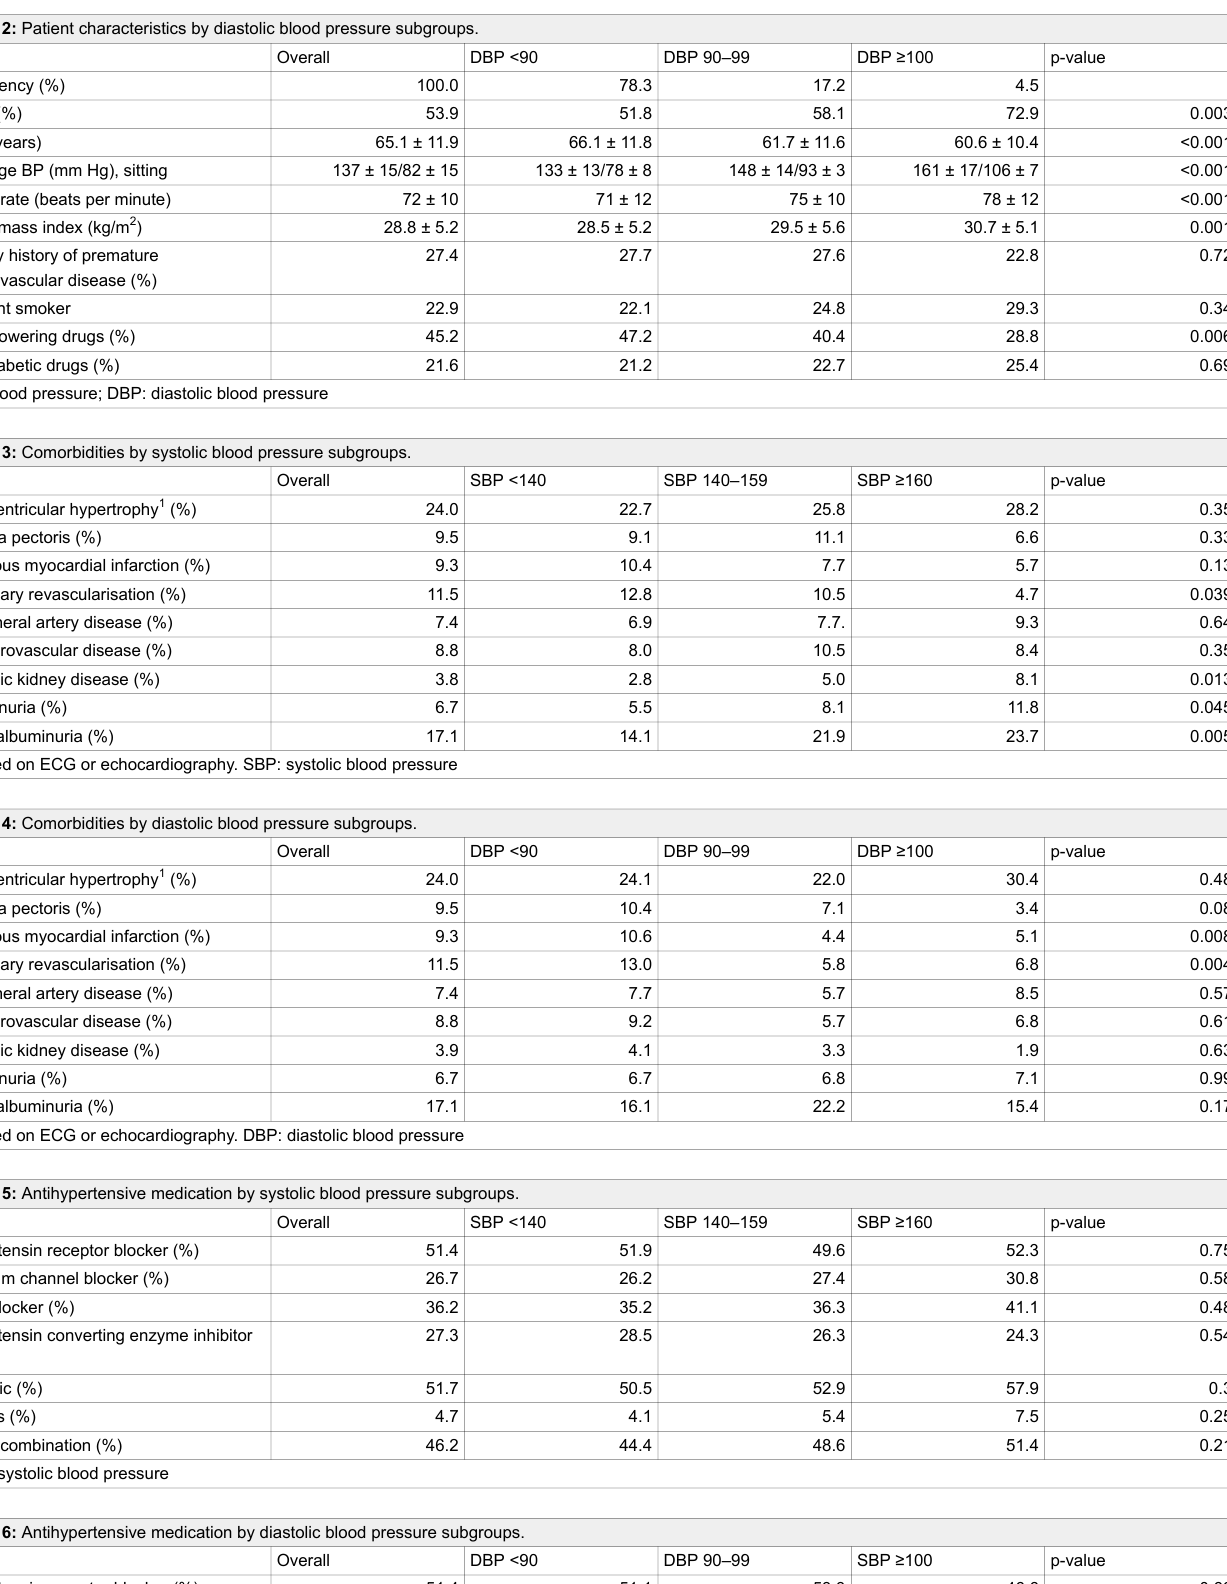
Table 6: Antihypertensive medication by diastolic blood pressure subgroups. Overall DBP <90 DBP 90–99 SBP ≥100 Angiotensin receptor blocker (%) Calcium channel blocker (%) Betablocker (%)